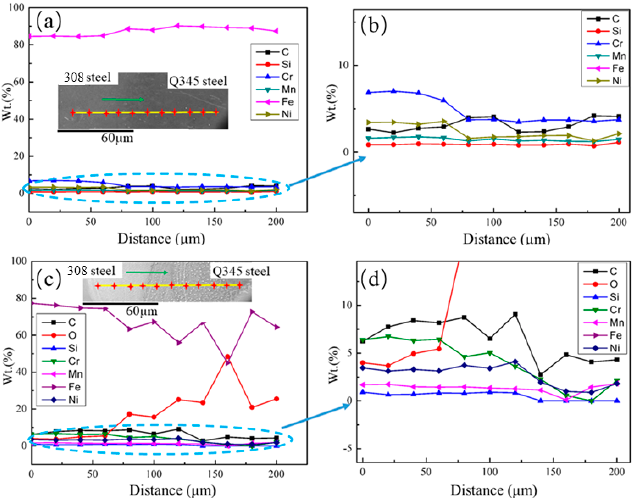
Figure 11. Element distribution curve near to the interface; ( a ) is the element distribution before corrosion, and ( b ) is the partial curve amplification of Figure 10a. Accordingly, ( c , d ) is the element distribution curve after corrosion.